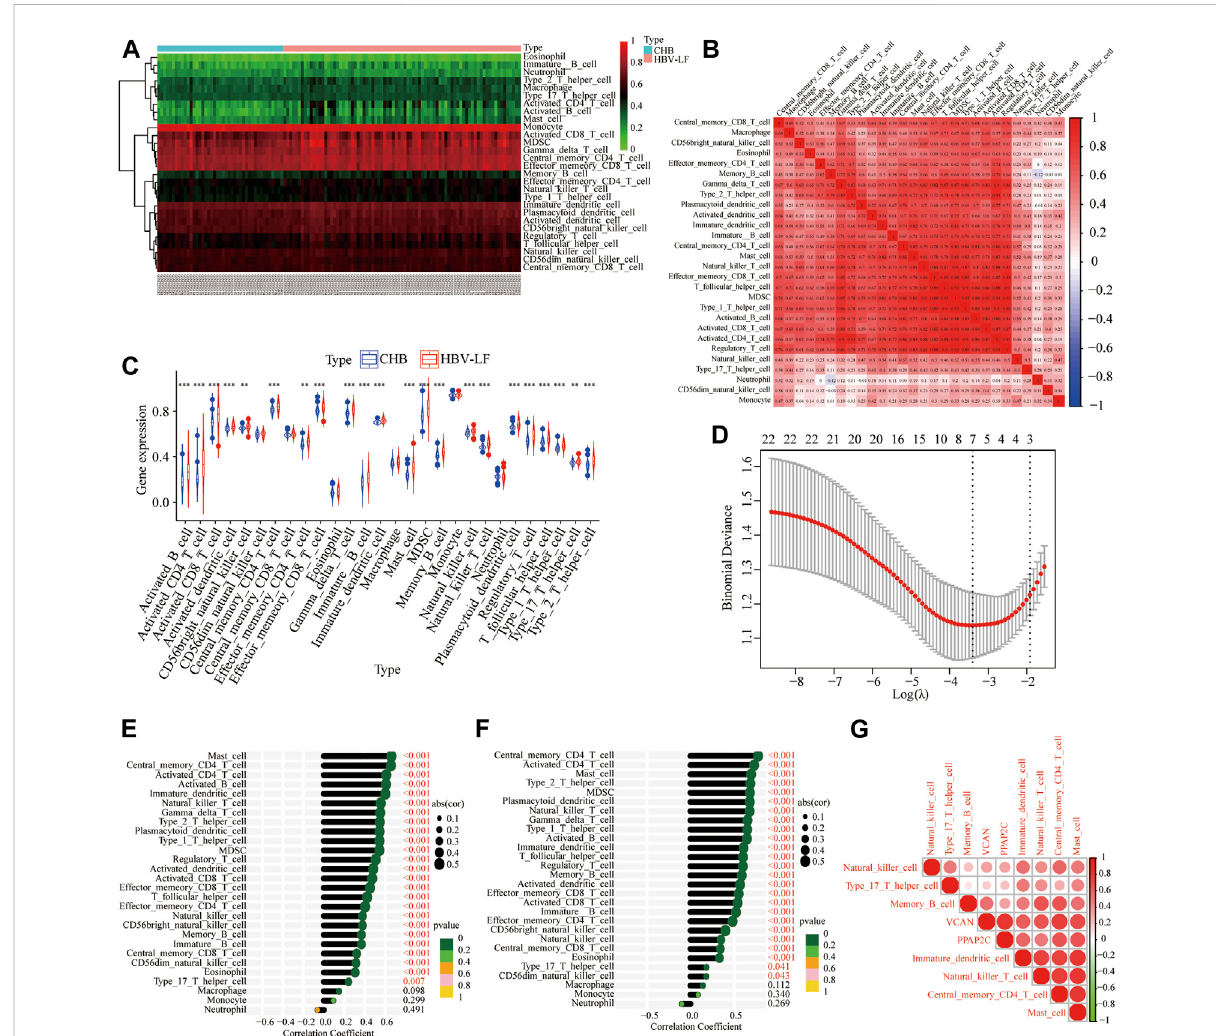
FIGURE 6 Immune cell in fi ltration pattern analyses of HBV-LF and CHB samples. (A) Heatmap of the immune landscape by ssGSEA algorithm. (B) Correlation heatmapof28immune cells. (C) Violin diagramof28immune cells. (D) LASSOanalysis toscreenthedifferentin fi ltratesofimmunecells. (E – G) Correlation between PPAP2C and VCAN and differential immune cells in